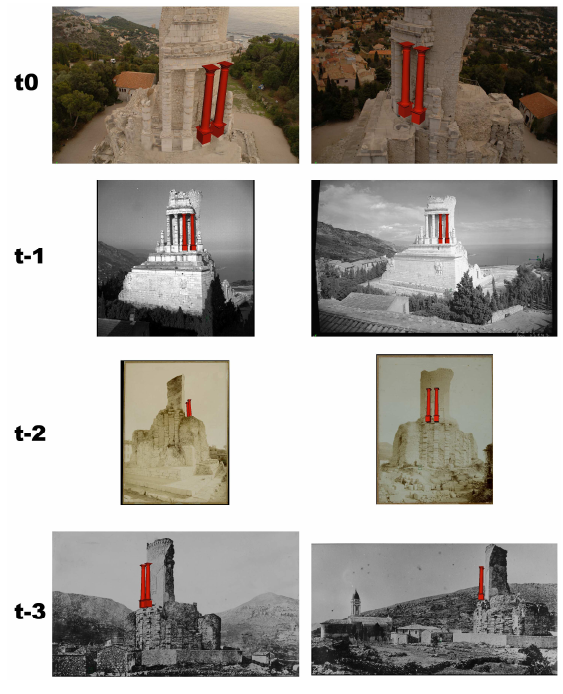
Figure 7. Spatial queries: entity-based searching of iconographic